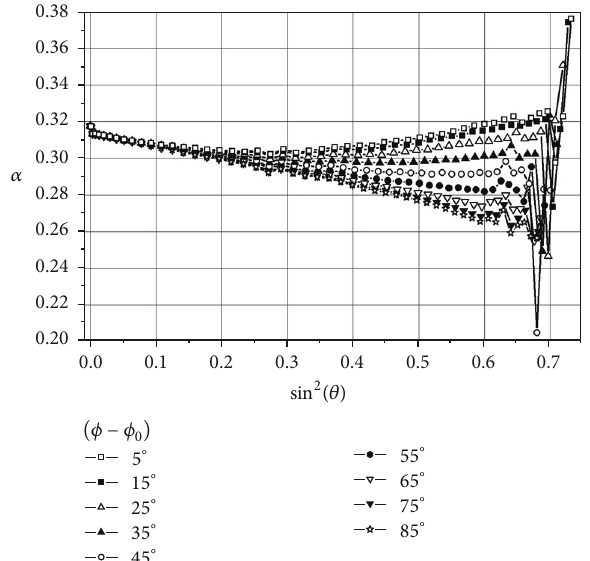
Figure 3: The attenuation factor for variant 𝑉 𝑃3 = 3200 .